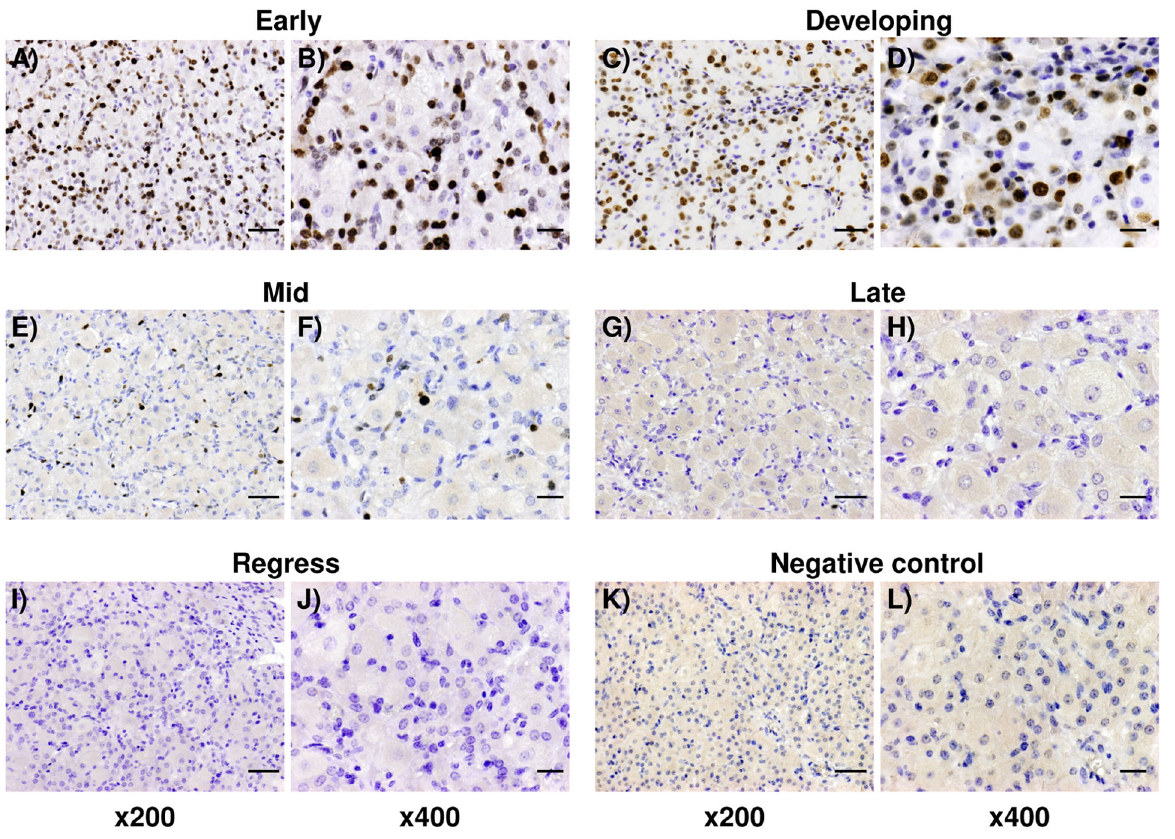
Figure 1. KI-67 expression in the bovine CL. Representative images of immunohistochemical staining for KI-67 in the bovine CL throughout the estrous cycle (A, B; early, C, D; developing, E, F; mid, G, H; late, I, J; regressed luteal stages). Scale bars represent 100 μm (low magnitude) and 50 μm (high